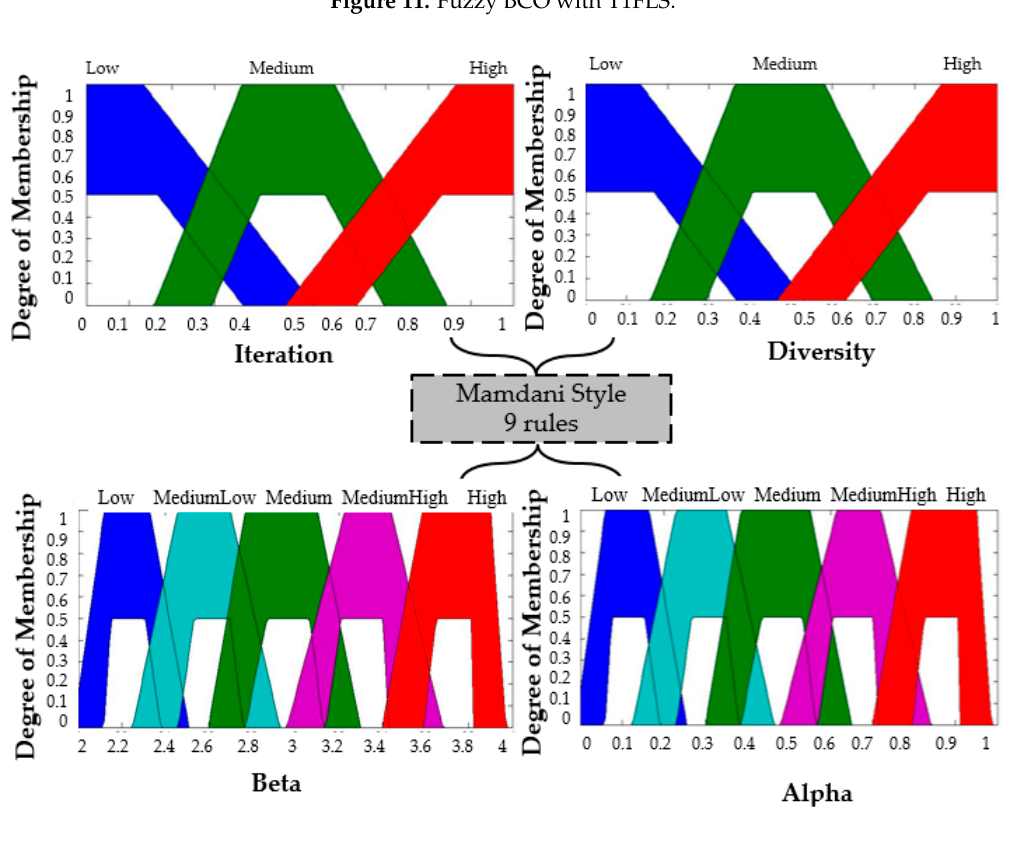
Figure 12. Fuzzy BCO with IT2FLS. Table 3. Rules for the Fuzzy BCO with dynamic adaptation of the beta and alpha parameter values.